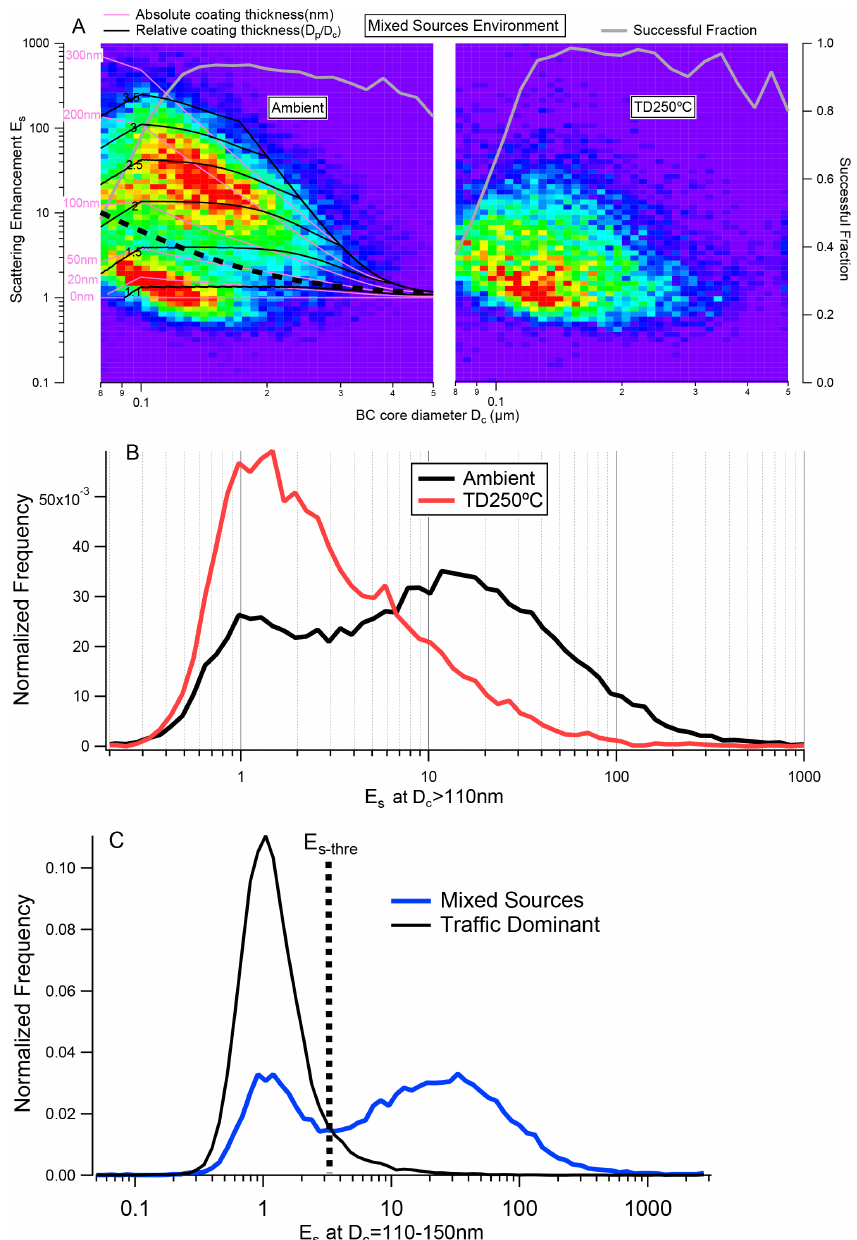
Figure 5. BC optical properties when environment is significantly influenced by solid fuel burning (31 January to 1 February when E air mass). The legends in the plot are identical with Fig. 4. In particular, the thick dotted black line on the left panel of (a) shows the reference line used to discriminate the BC from traffic or solid fuel burning source. (c) the E s distribution at D c = 110–150nm for the traffic and mixed sources, with the dotted line showing the determination of E s-thre